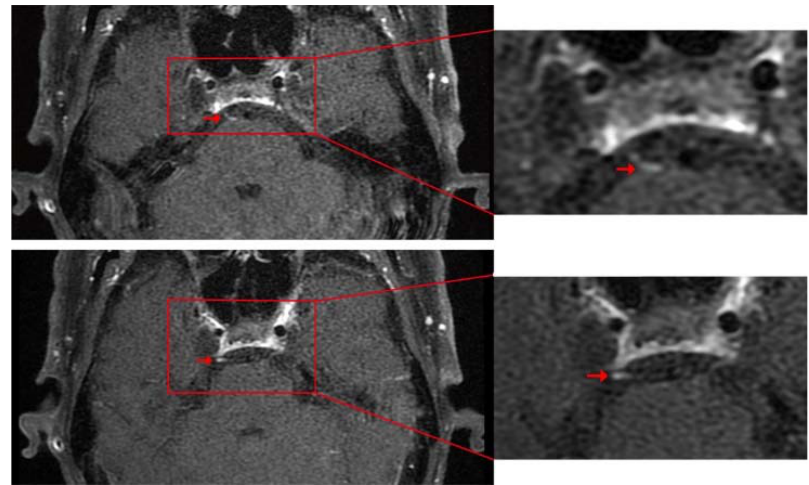
Figure 2. Post-contrast Axial T1WI. There is marked enhancement and thickening of the right abducens nerve (right arrow).